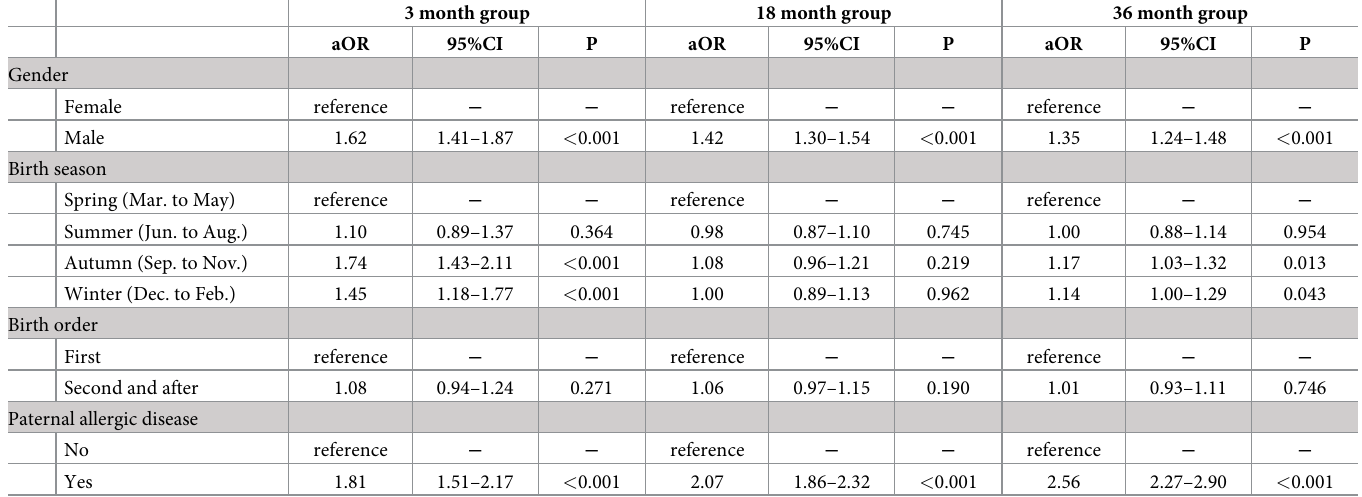
Table 7. Multivariable analysis between wheeze and eczema and covariates in the three age